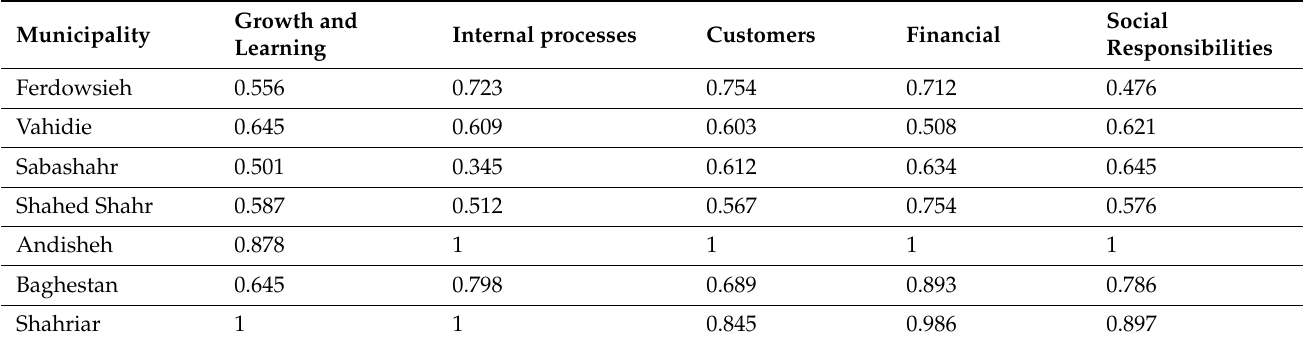
Table 9. Serial evaluation results.